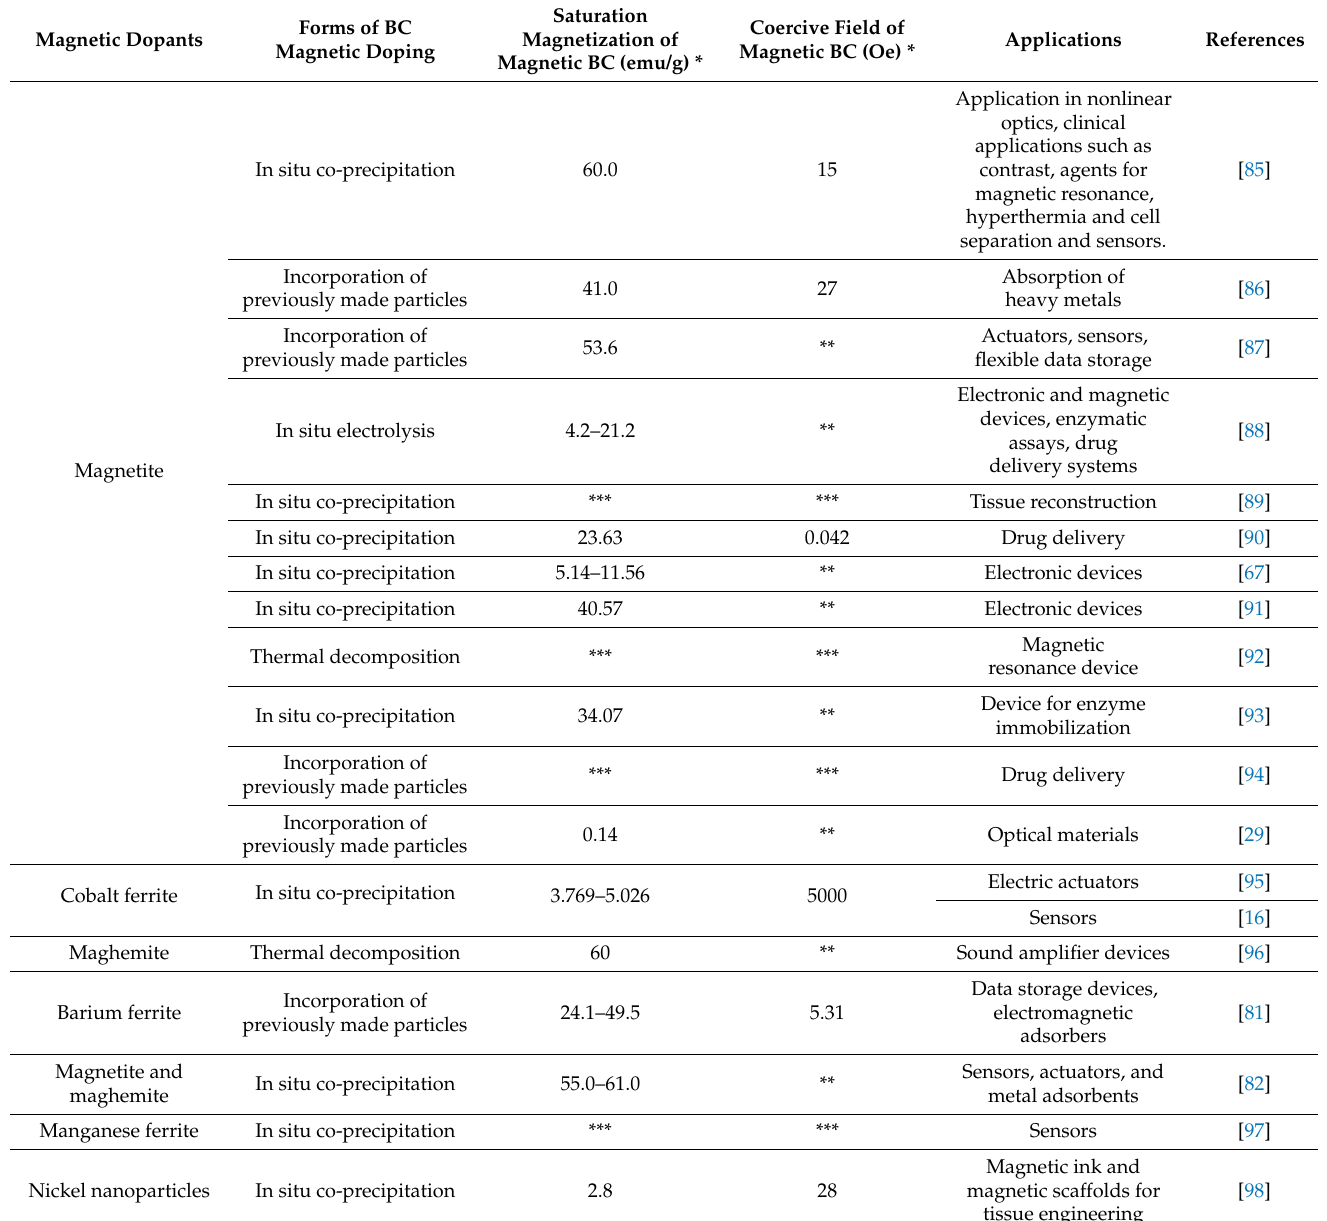
Table 3. Magnetic materials added to BC and respective